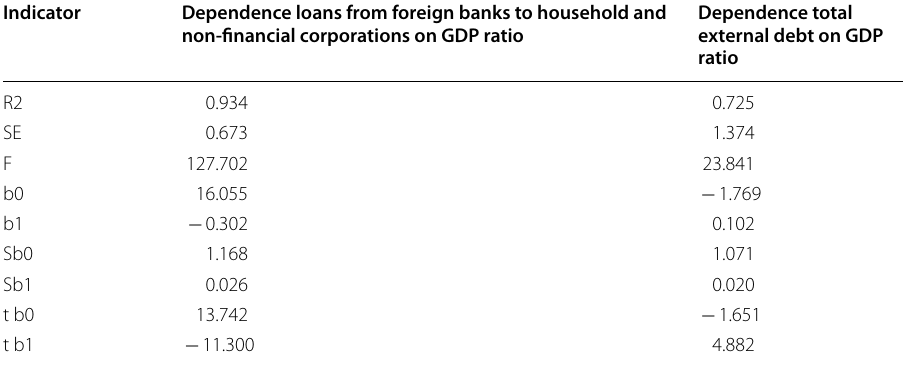
Sources Author’s